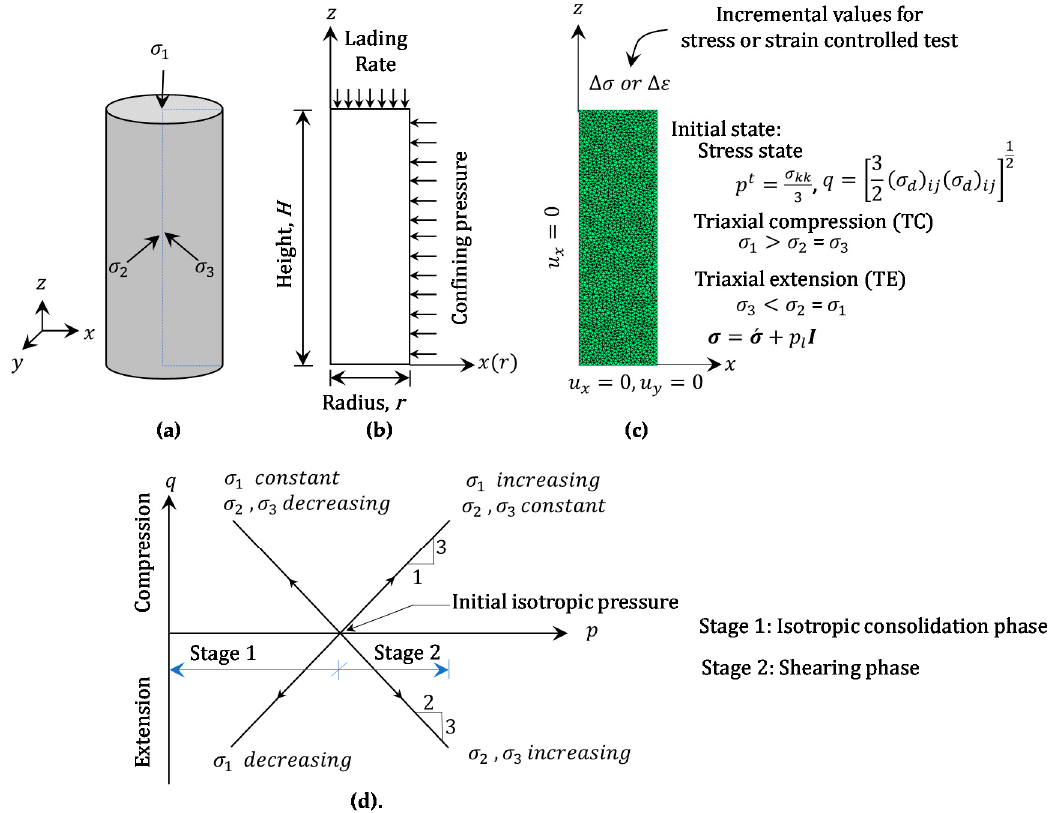
Figure 8. TheCambridgestressstateinaconventionaltriaxialtest( a )acylindricalsample,( b Figure 8. The Cambridge stress state in a conventional triaxial test ( a ) a cylindrical sample, ( b ) an axisymmetric section, ( c ) a finite element mesh and ( d ) p-q diagram for loading state (see also Lade [29] ), p. 62).